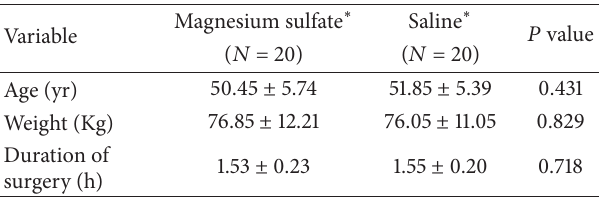
Table 1: Demographic characteristics of patients in two magnesium sulfate and saline